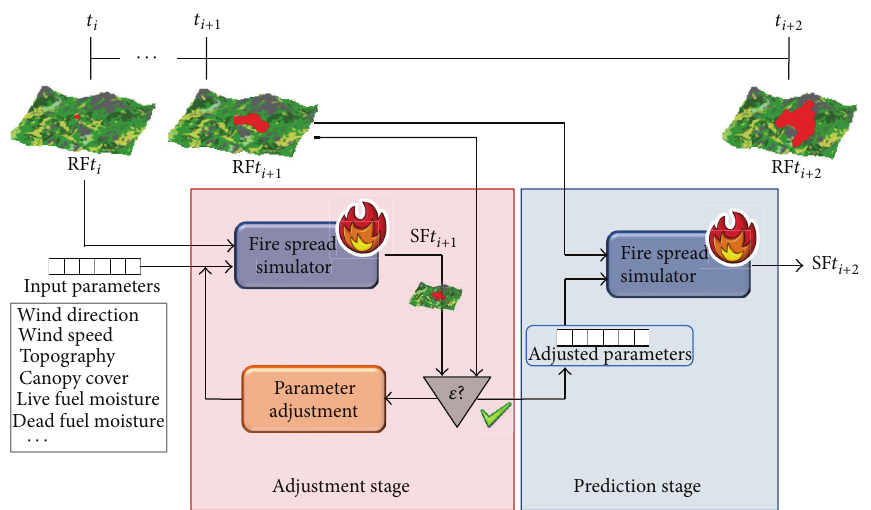
Figure 2: Two-stage prediction